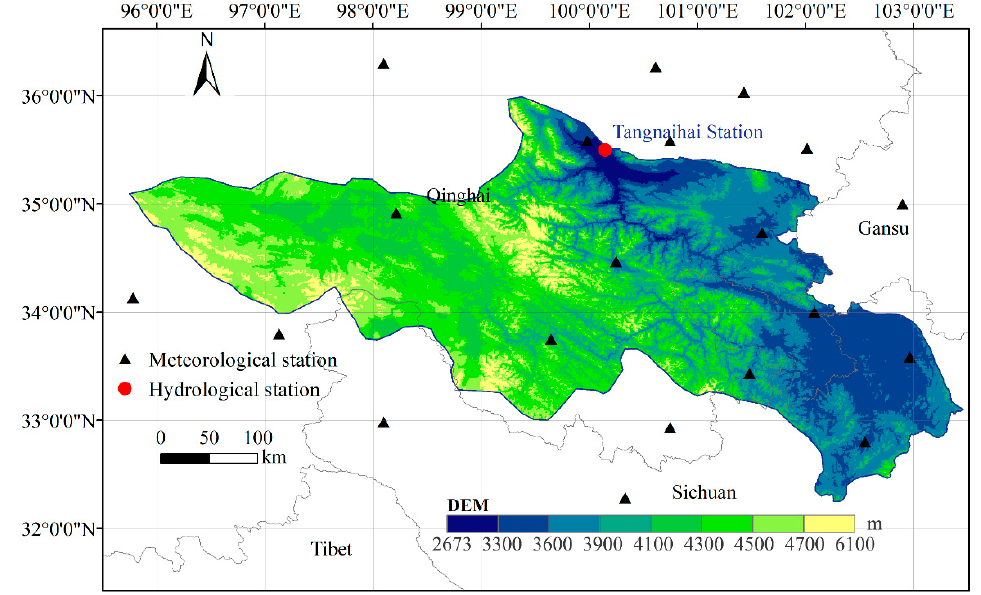
Figure 1. The location of hydrological and meteorological stations in the source area of the Yellow River Basin.